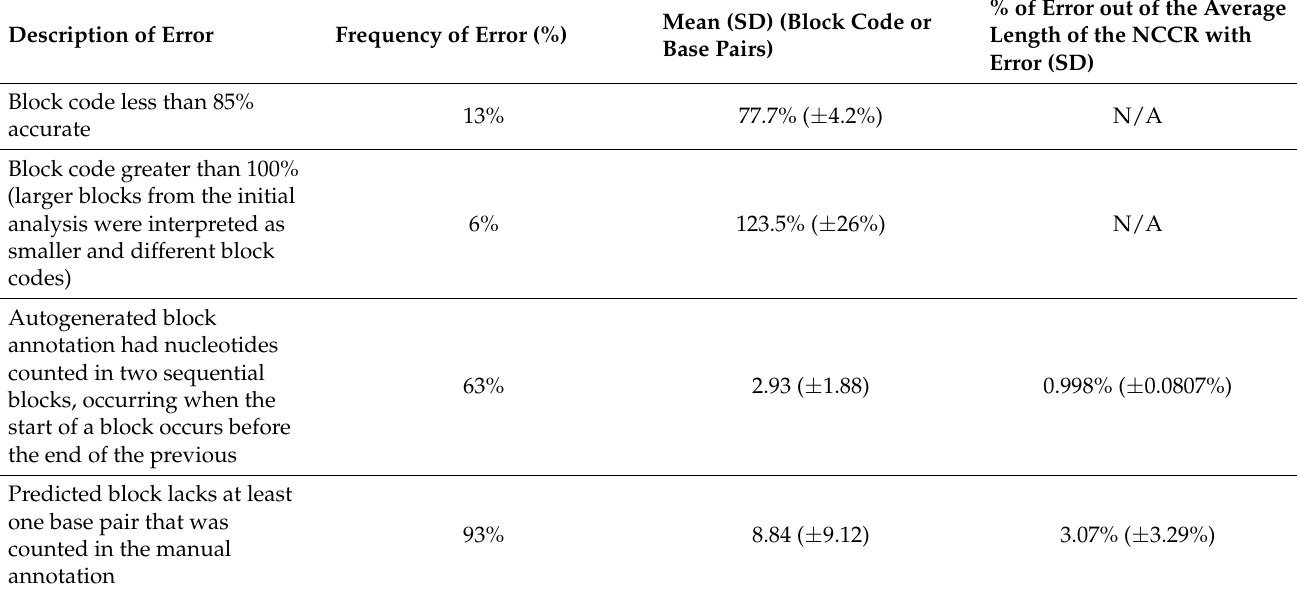
Table 4. Summary comparing 100 NCCR sequences from the automated script to the initial, man- ual